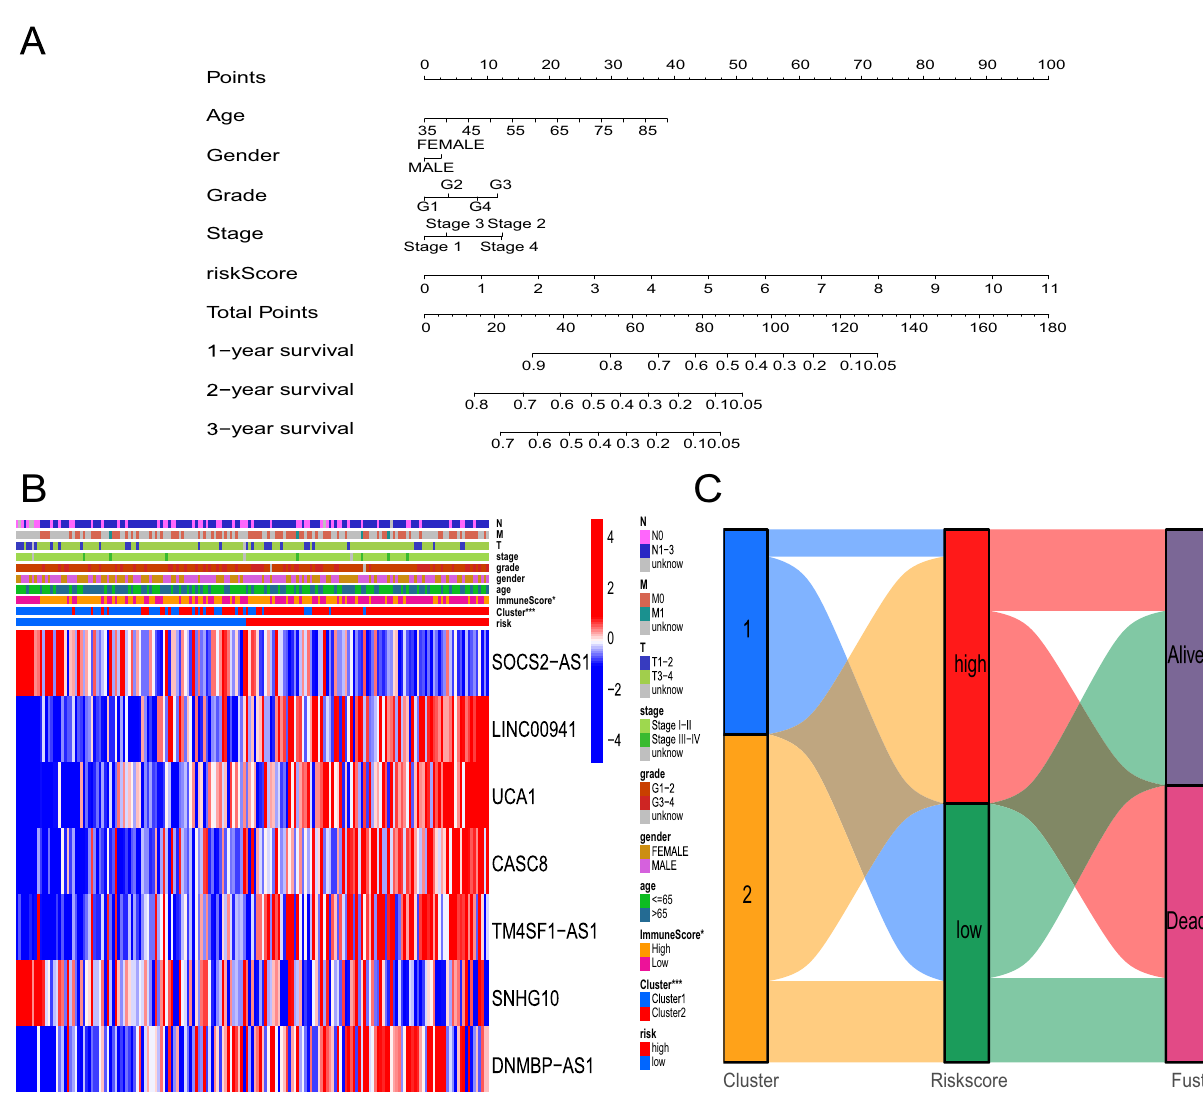
Figure 6. Nomogram construction and evaluation. ( A ) Nomogram for predicting the prognosis of patients with pancreatic cancer. ( B ) Heatmap showing the differential expression of the model lncRNAs. ( C ) Sankey diagram of cluster, risk score, and survival